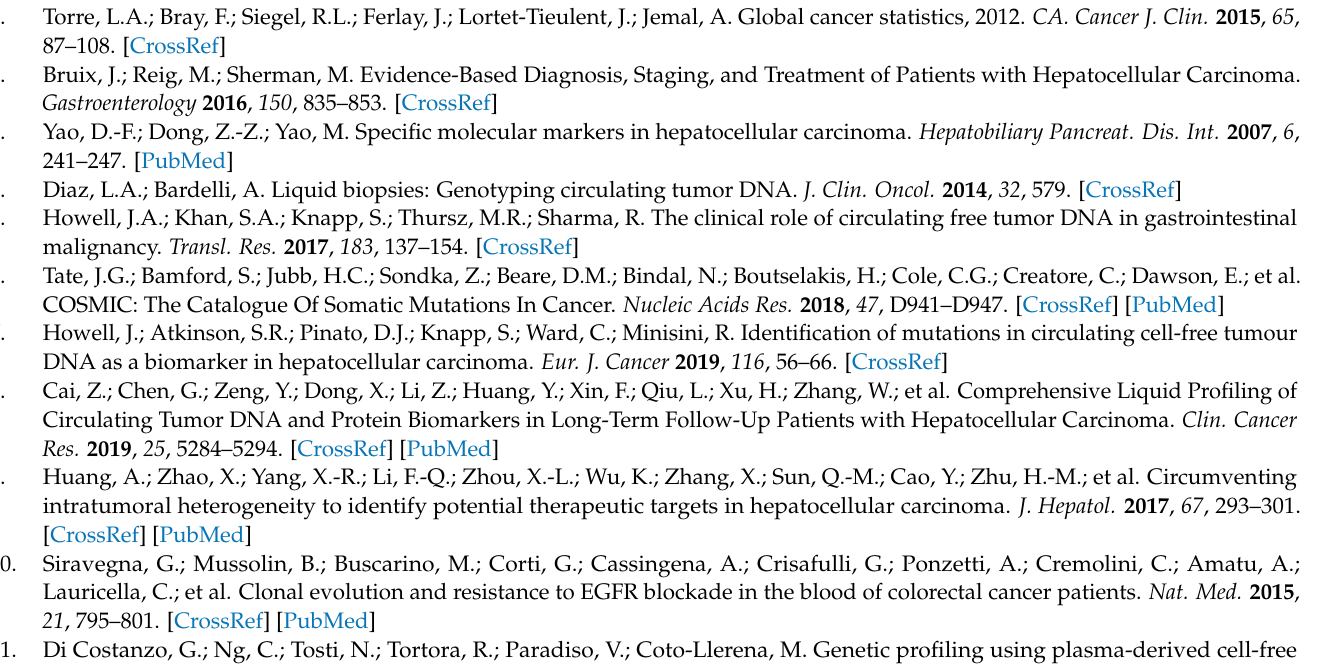
using WES. Figure S7: CNVs in HCC tumor DNA from SMURF-seq. Figure S8: Overview of this study. Table S1: Baseline characteristics of patients with HCC for cfDNA evaluation. Table S2: Summary of 30 cfDNA whole-exome sequencing samples. Table S3: Summary of mutation types in 30 cfDNA samples from HCC patients. Table S4: Baseline characteristics of patients with HCC for SMURF-seq. Supplementary Information S1: Whole-exome sequencing analysis